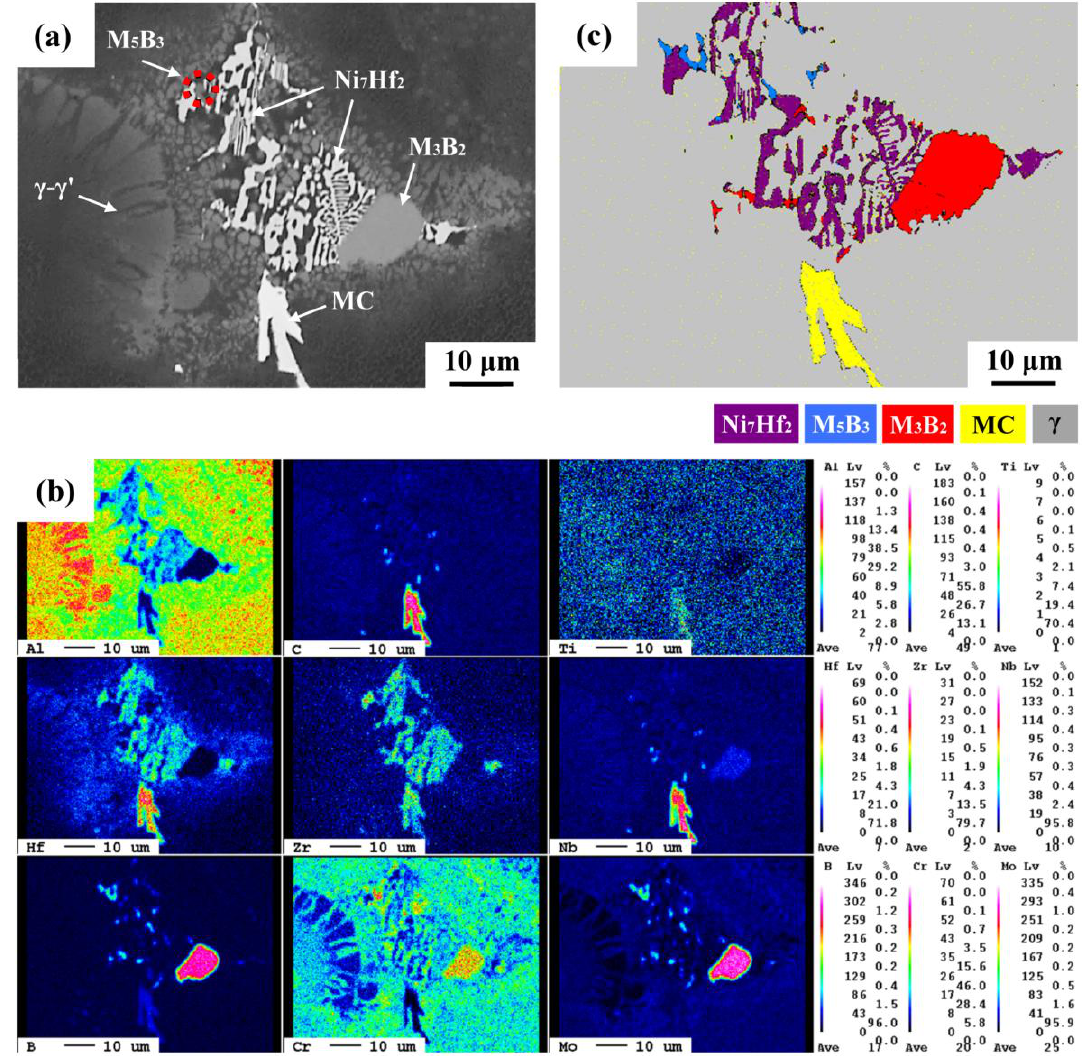
Figure 5. The identification of complex grain boundary microconstituents: ( a ) BSE image showing the interdendritic microconstituents ahead of γ-γ′ colonies; ( b ) the elemental maps of the boundary microconstitutents determined by electron probe micro-analyzer (EPMA); and ( c ) the EBSD map to distinguish the MC carbide, borides, and lamellar intermetallics.